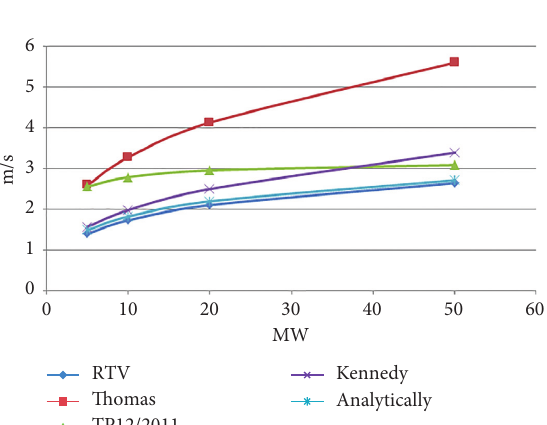
Figure 7: Comparison of various ways of critical velocity calculation.